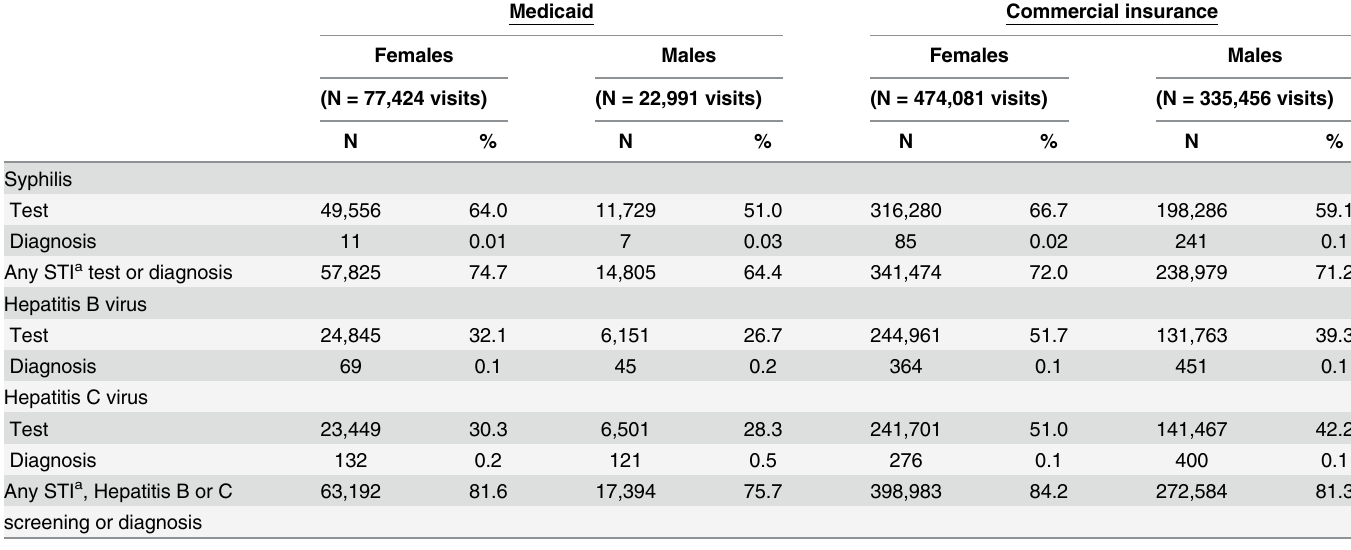
Table 5. Tests and diagnoses for sexually transmitted infections, hepatitis B virus, and hepatitis C virus during visits with an HIV test among tests for females and tests for males, Medicaid and commercial insurance,